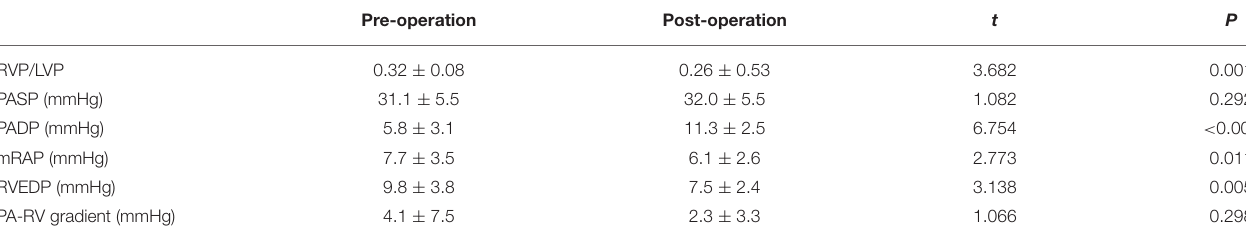
TABLE 3 | Hemodynamics data in